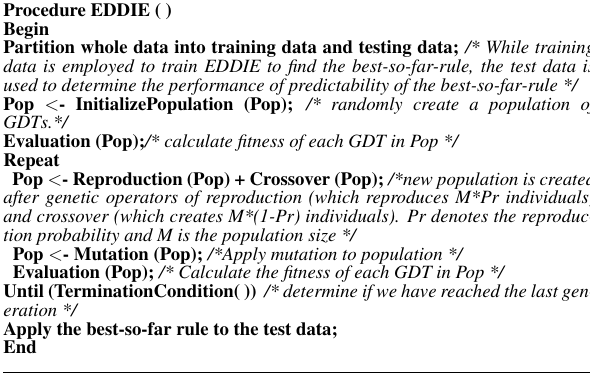
Figure 2 Pseudo code for the procedure that EDDIE fol- lows. (Based on Li’s work 28 ,